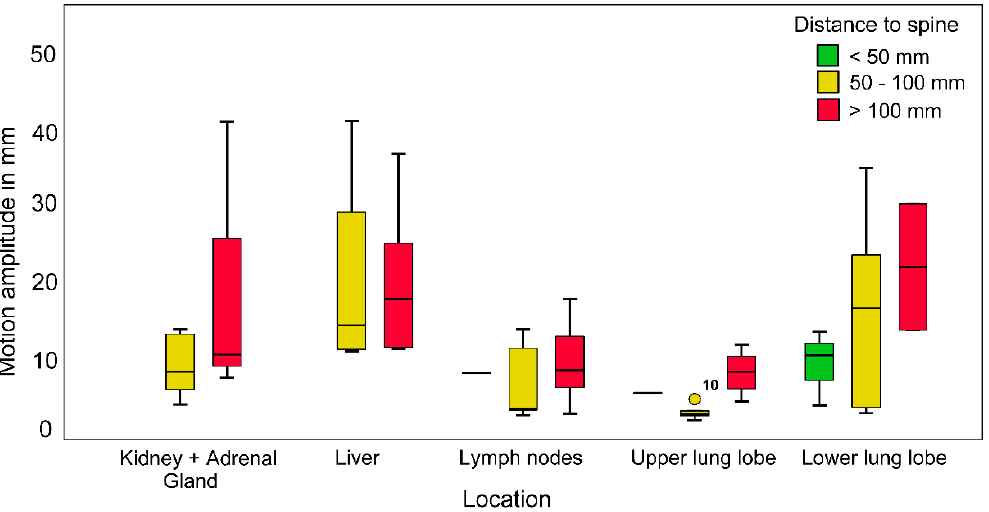
Figure 3. Maximum motion amplitudes of Synchrony-tracked lesions for different tumor locations. The distance from the spine is represented by different colors (green: <50 mm, yellow: 50–100 mm, red: >100 mm). Boxplots show the medians and interquartile ranges, and circles indicate outliers.